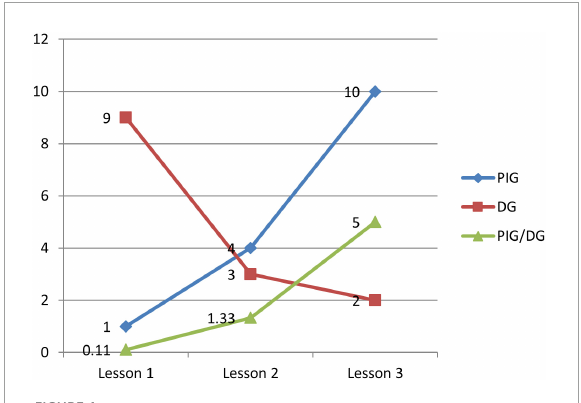
FIGURE4 Comparison of emotional communication at the three